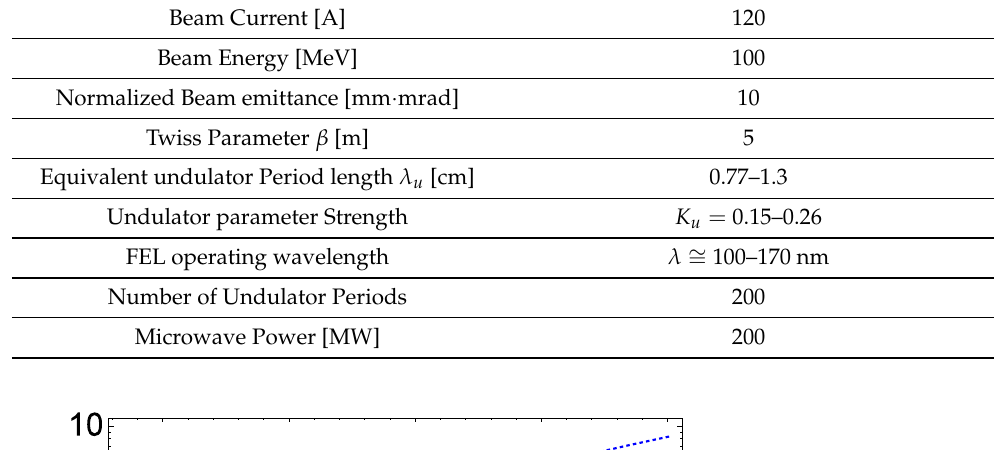
Table 2. Same as Table 1 for the UV operation. Regarding the relative energy spread, we have assumed a linear scaling with the inverse of the energy. Therefore, with respect to the case of Table 1, we foresee σ ε = 5 × 10 − 4 .